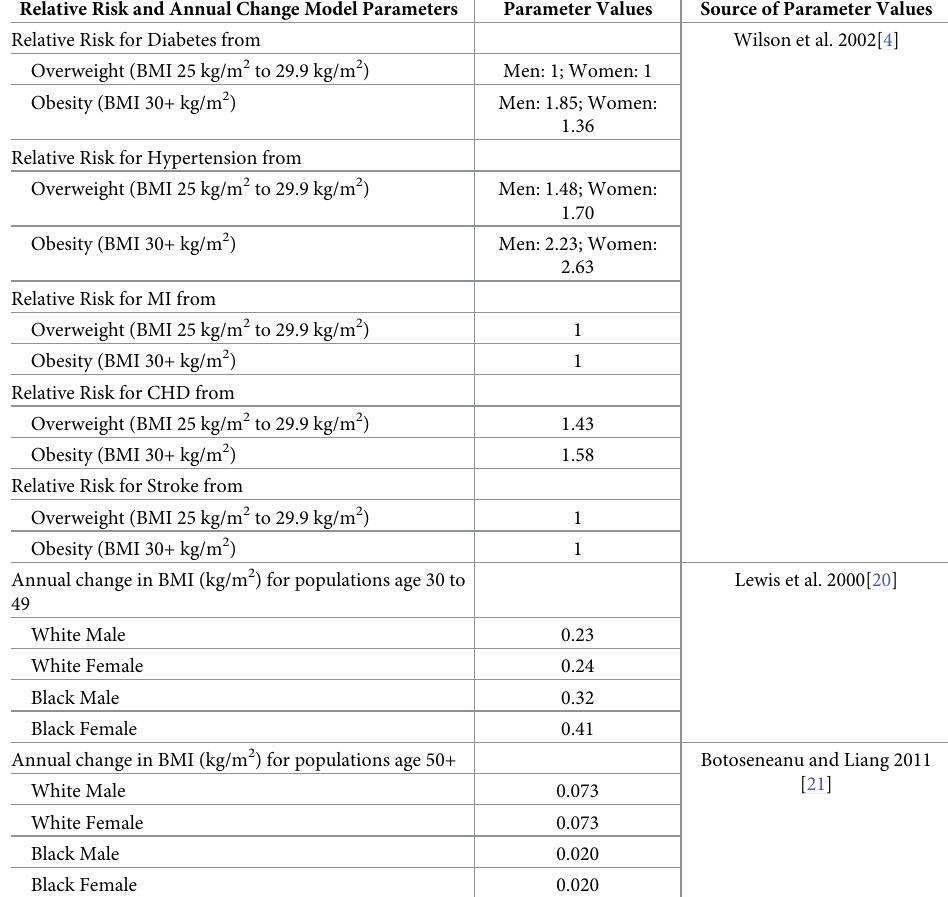
Lewis et al. 2000[20] 0.23 0.32 0.41 [21] 0.073 0.073 0.020